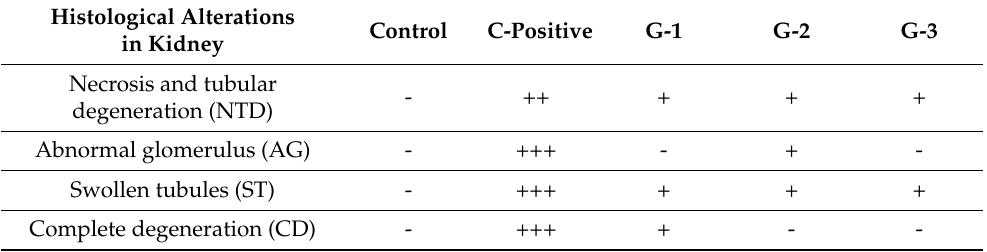
Table 6. Comparison of various histological abnormalities in the kidneys of common carp from control and treated groups. Please note that five fields of one histological section per sample were analyzed. Histological Alterations in Kidney